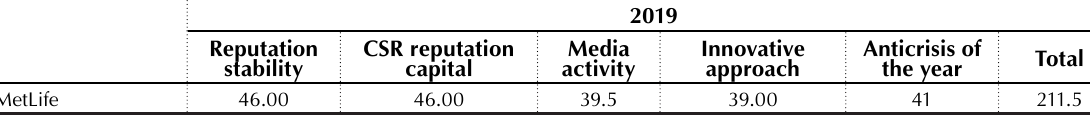
Table 4. Results of IC “MetLife” ranking for 2019